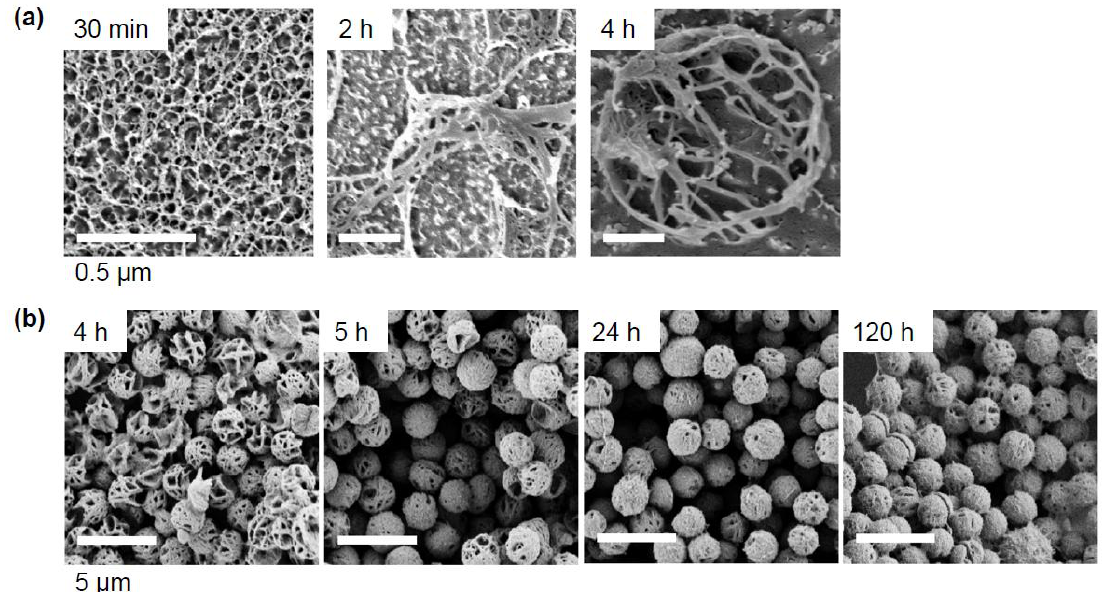
Figure 9. Evolution of the morphology produced during the annealing of a 1 wt% aqueous solution of PiPrOx as visualized by ( a ) cryogenic scanning electron microscopy ( t ≤ 4 h) and ( b ) conventional scanning electron microscopy ( t ≥ 4 h); the onset of crystallization occurred at t ~ 4 h (WAXS) [102], reproduced by permission of the Royal Society of